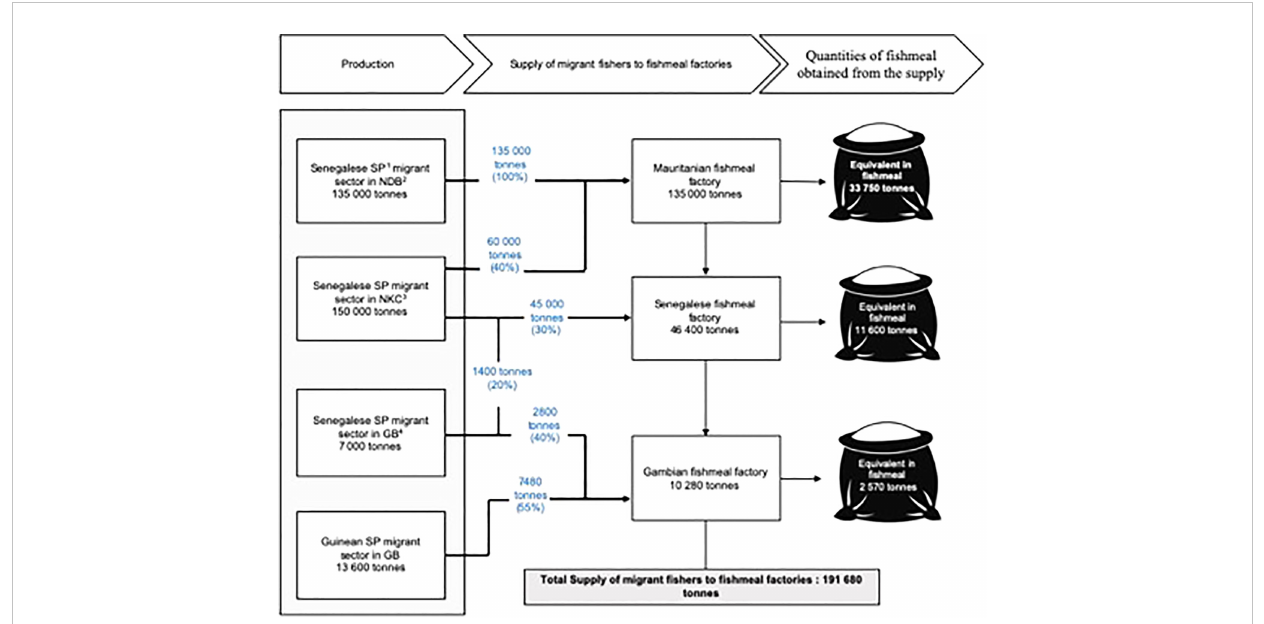
FIGURE 4 Estimated supply of small pelagics to fi shmeal factories by migrant fi shers over the period 2012 – 2018. Source: Field surveys. 1 SP, Small pelagic; 2 NDB, Nouadhibou; 3 NKC, Nouakchott; 4 GB, Gambia